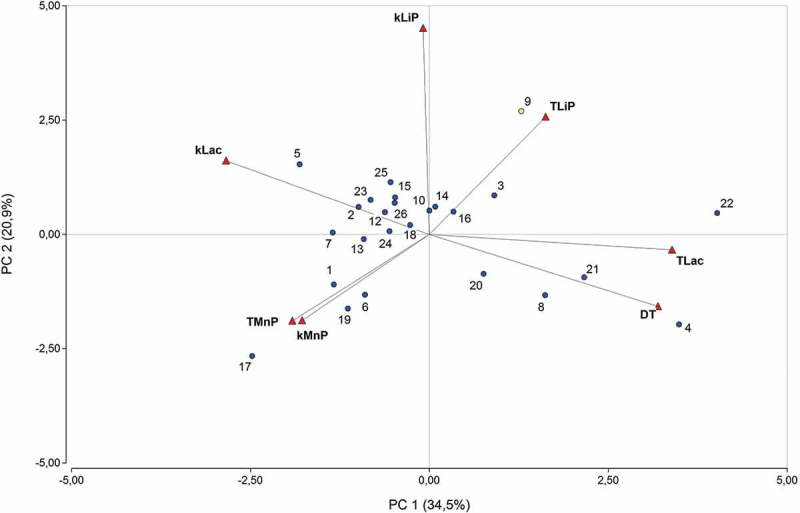
Score plot of PC1 vs PC2 illustrating the distribution of WRF, plotting with all variables. Fungal identification numbers are displayed in Table 1.